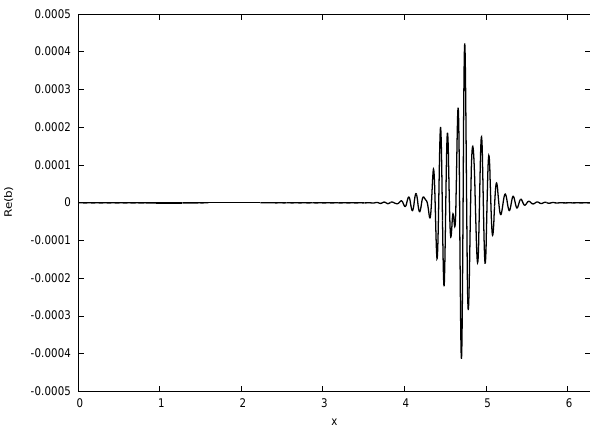
Fig. 4. Initial condition with two breathers. Figure 4. Initial condition with two breathers. Figure 4. Initial condition with two breathers. Figure 4. Initial condition with two breathers. Figure 4. Initial condition with two breathers.